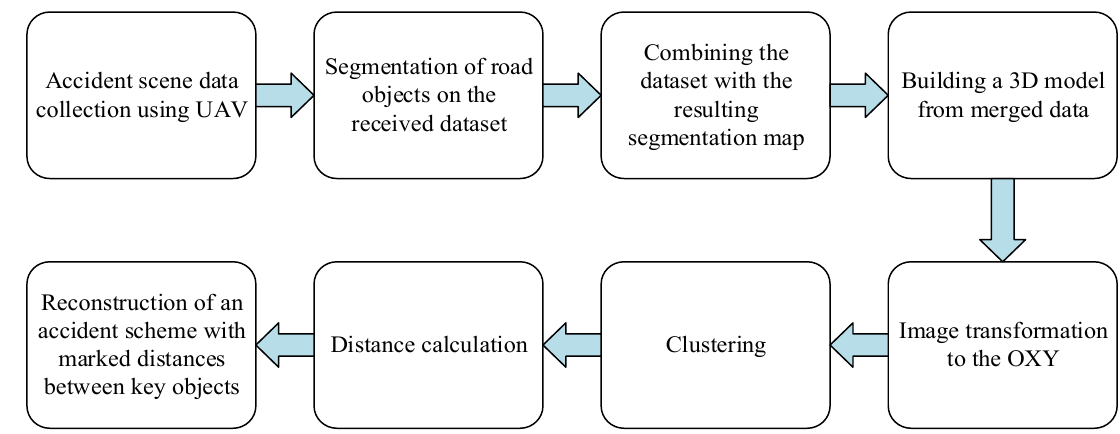
All intermediate results obtained during the processing of a set of images of an acci- Figure 12. Stages of the approach to the autonomous construction of a road accident map. Figure 12. Stages of the approach to the autonomous construction of a road accident map. dent scene are shown in Figure 13.